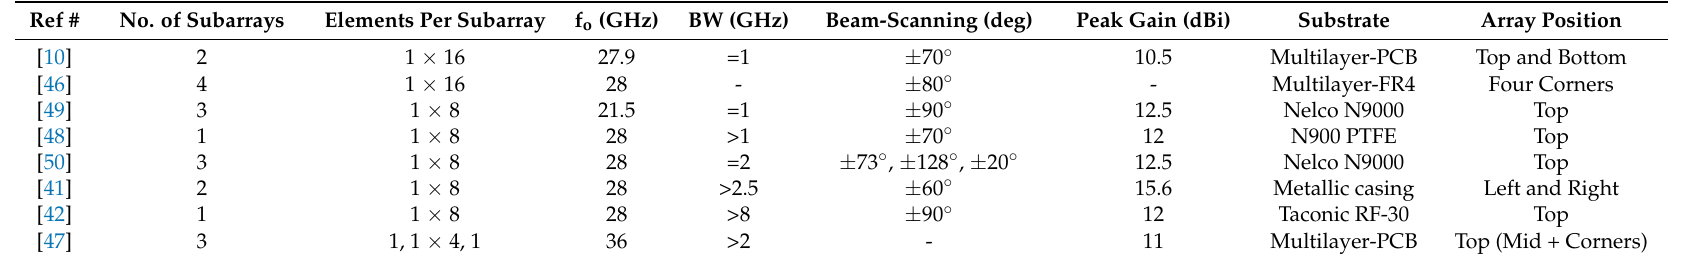
Table 1. Performance variation of various phased arrays for 5G mobile